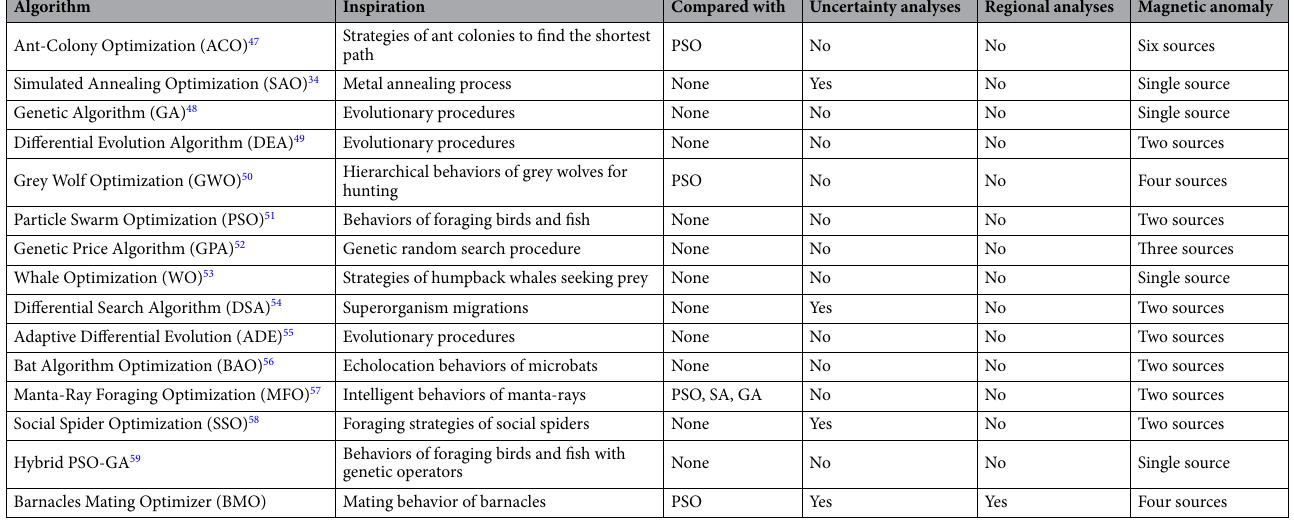
Table 1. Magnetic anomaly inversion studies carried out in recent years with global optimization algorithms and the presented